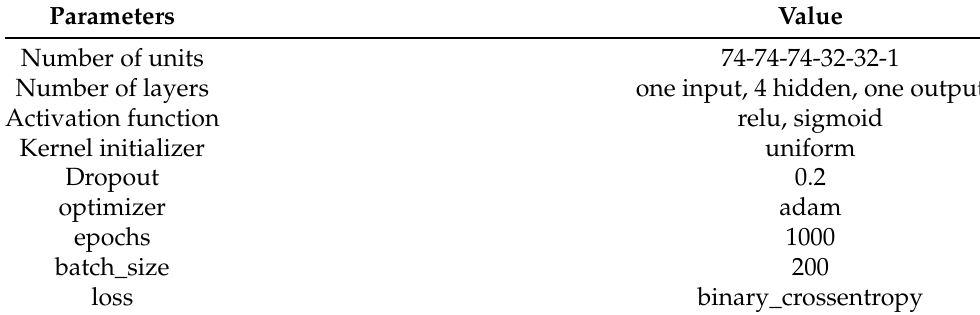
Figure 6. Built DL model. Table 2. Best hyper-parameters.